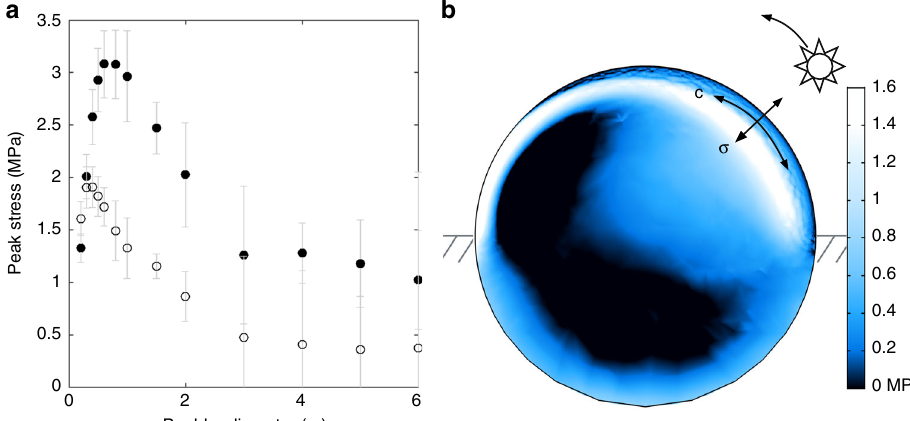
Fig. 4 The magnitude and distribution of exfoliating stresses. a Peak exfoliating stress in boulders of varying diameter that are dense (solid circles) and porous (open circles). Error bars represent the uncertainty due to mesh resolution and location (see “ Methods ” section). b Stress in a cross section of 2 m boulder at mid-morning. Lines show the orientation of the exfoliation stress fi eld ( σ ) in the boulder ’ s eastern near-surface and resulting direction of crack propagation (c). Black regions have negative (compressional)